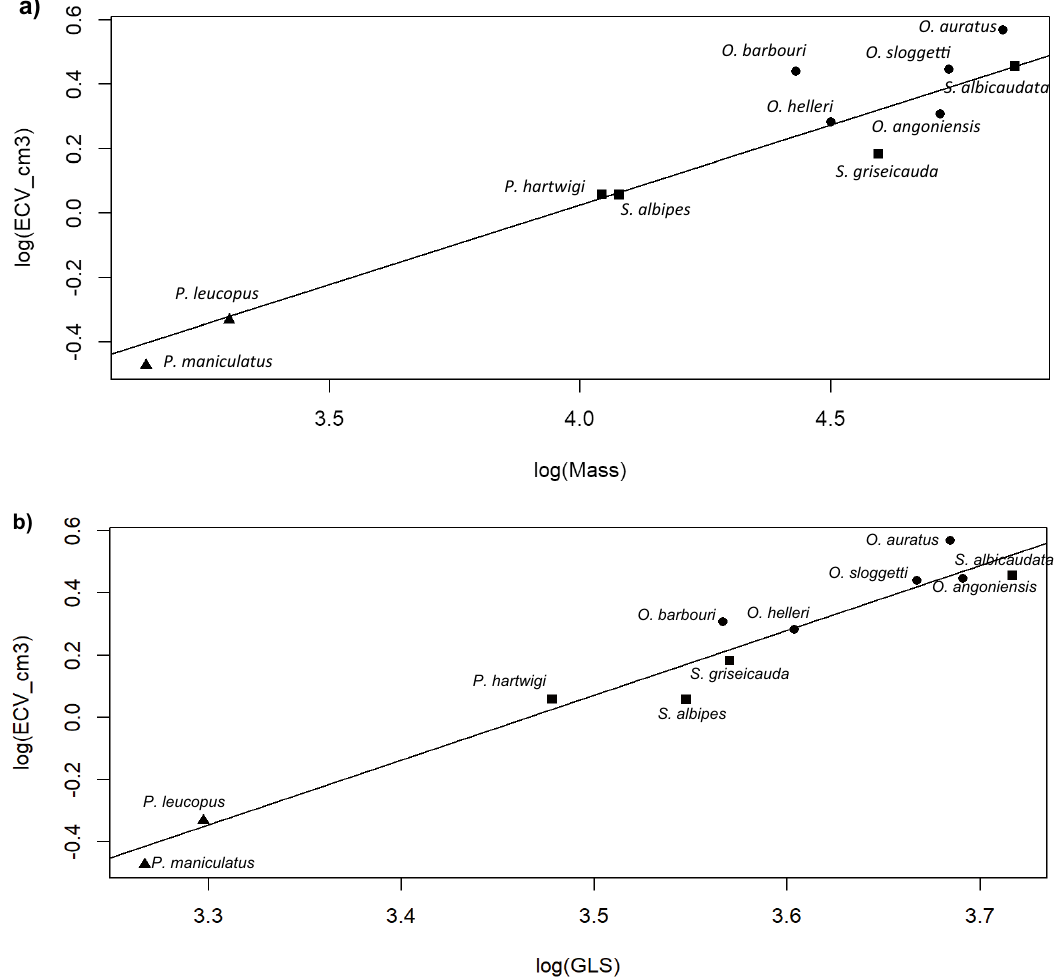
Figure 1. Phylogenetically-controlled regressions (models shown as solid lines) between logged mean species values of endocranial volume (ECV_cm3) and a) body mass and b) skull length (GLS) between three rodent clades; Peromyscus (triangles), Otomyini (dots), Praomyini (squares). Means for ECV and skull length were computed from 113 individual crania (Table S1). Mean body masses obtained from literature 71,72